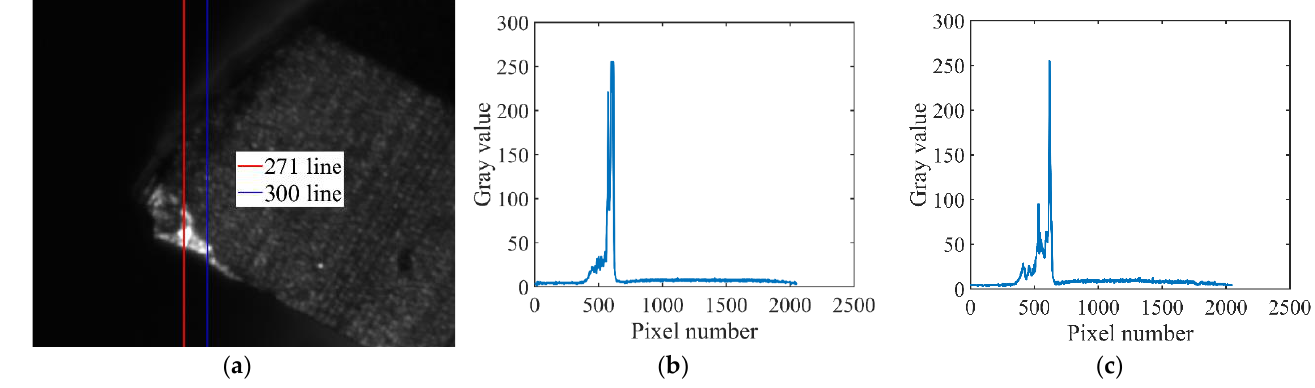
Figure 5. Grayscale distribution map. ( a ) Original image; ( b ) 271-column pixel gray curve; ( c ) 300-column pixel gray curve.